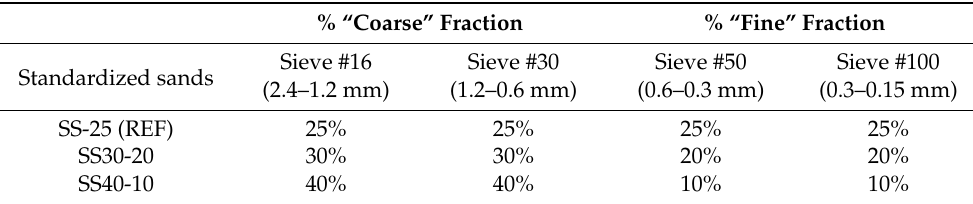
Table 1. Particle size fractions and nomenclatures of standardized sands.